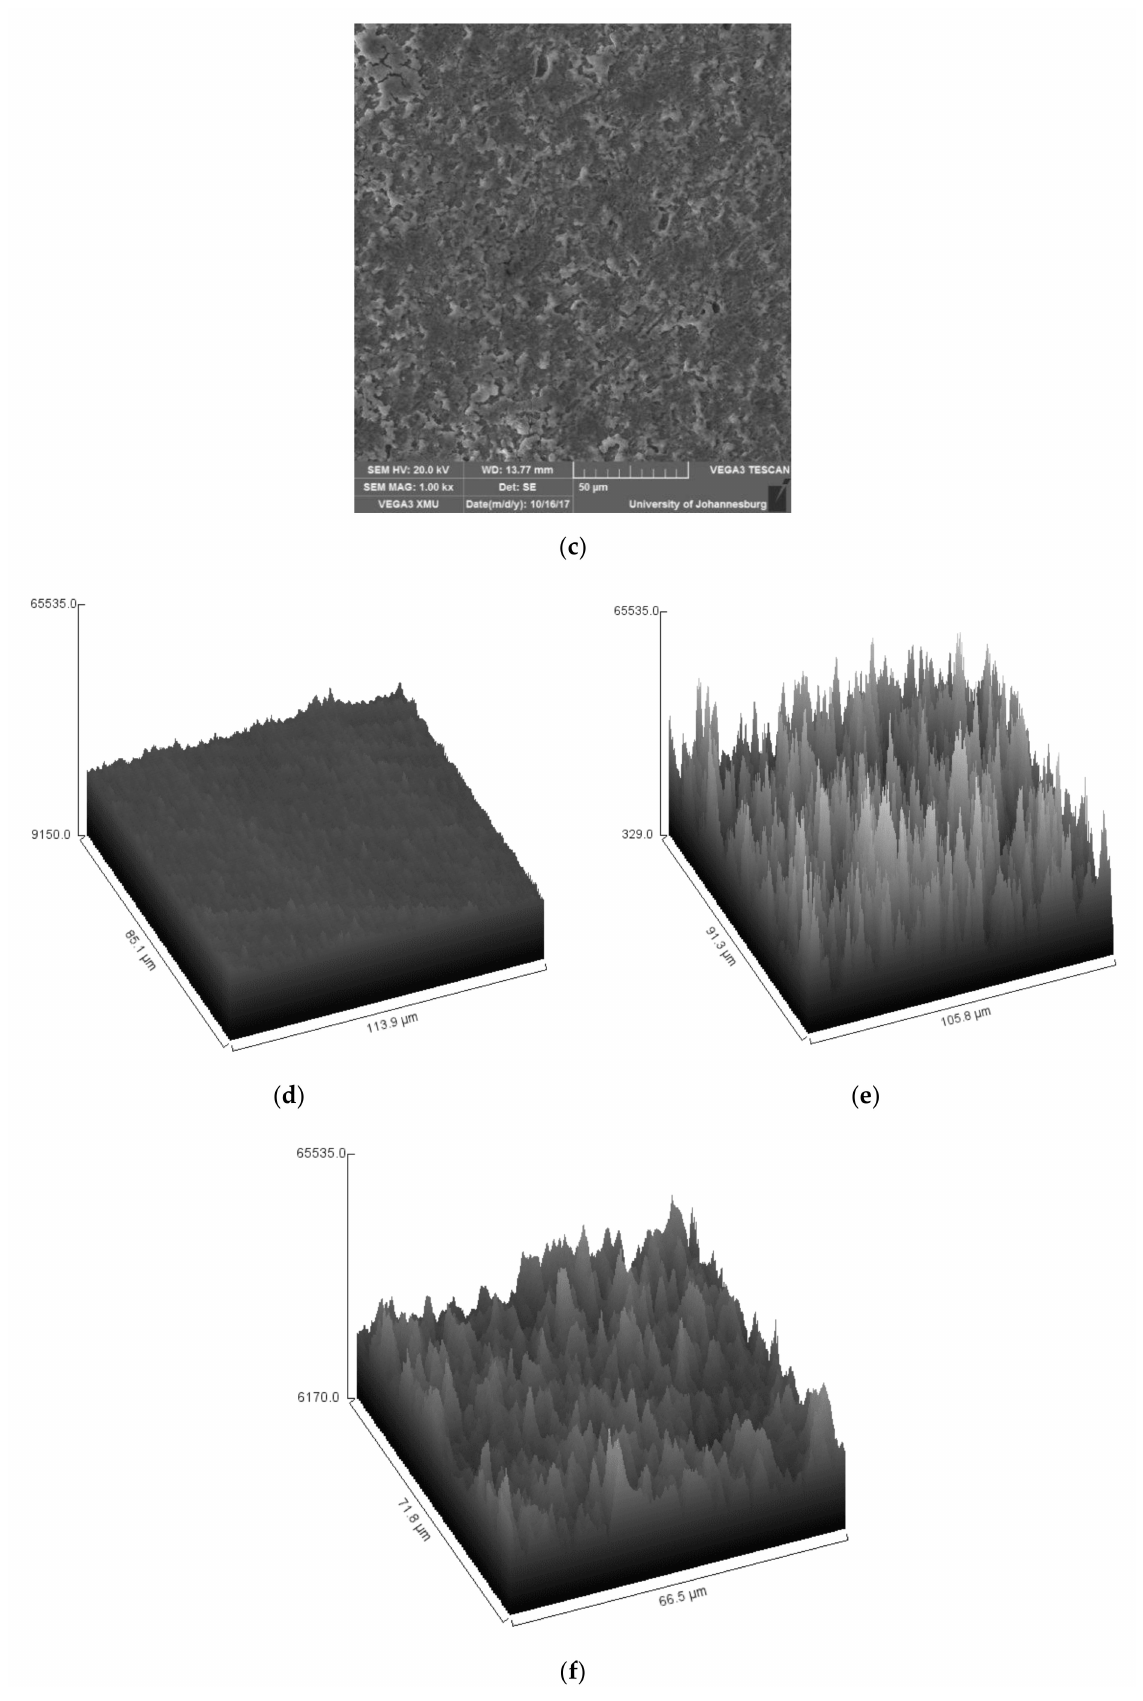
Figure 12. SEM micrograph of ( a ) una ff ected, ( b ) blank solution ( c ) 600 ppm PBSLP and surface plot of ( d ) una ff ected, ( e ) blank, and ( f ) 600 ppm PBSLP,